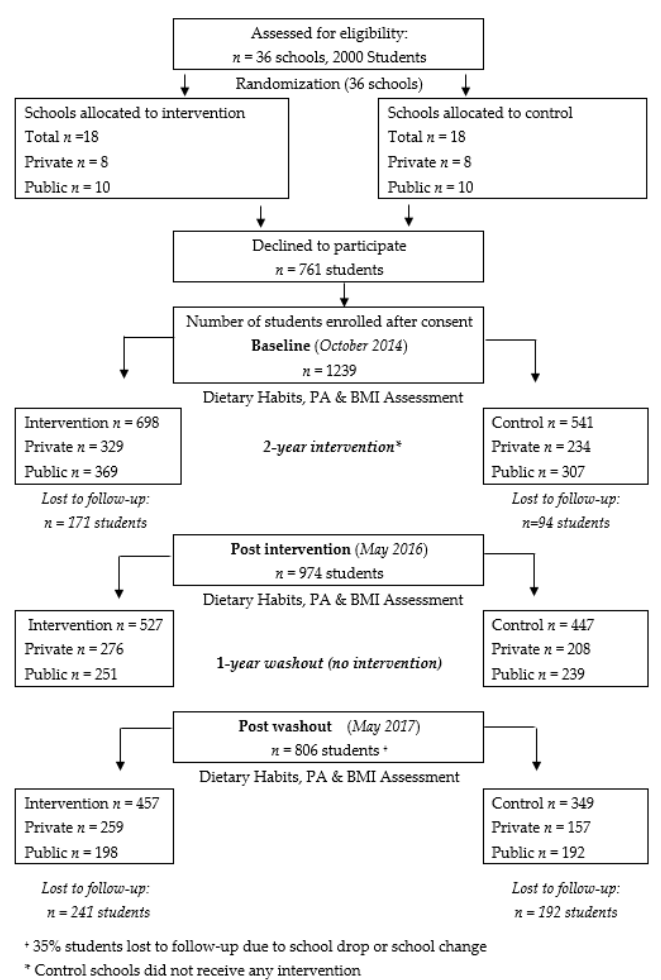
Figure 1. Flowchart illustrating students’ recruitment, sample retention and data collection in both groups from baseline to study completion.